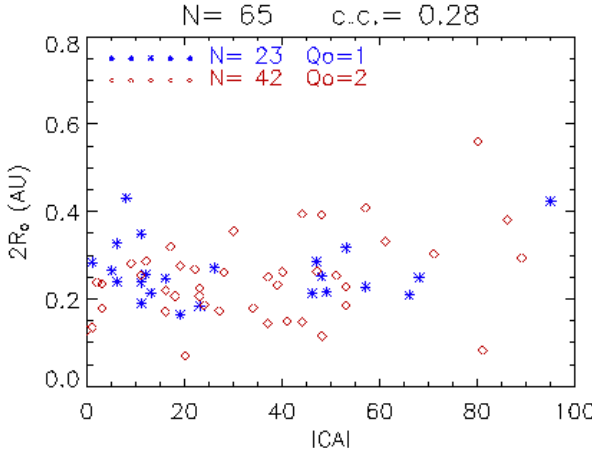
Fig. 7. A plot of the estimated diameters of the MCs (2 R O ) vs. | CA | (in %) for the combined Q O =1,2 cases ( N =65), where c.c.=0.28, and where each quality-set is shown separately: for Q O =1 ( N =23, by * in blue) and for Q O =2 ( N =42, by diamonds in red). Figure 7. A plot of the estimated diameters of the MCs (2 R O ) vs. |CA| (in %) for the combined Q O = 1,2 cases (N = 65), where c.c. = 0.28, and where each quality-set is shown separately: for Q O = 1 (N = 23, by * in blue) and for Q O = 2 (N = 42, by diamonds in red).